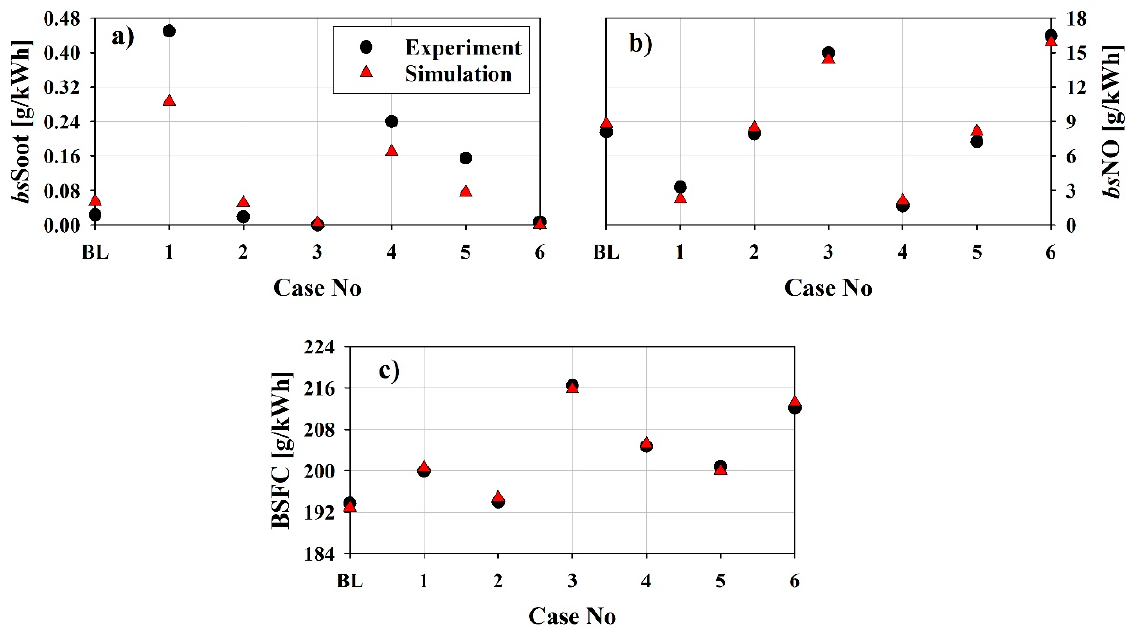
Figure 8. Experimentally measured and model predicted ( a ) bsSoot, ( b ) bsNO and ( c ) brake specific fuel consumption (BSFC) .